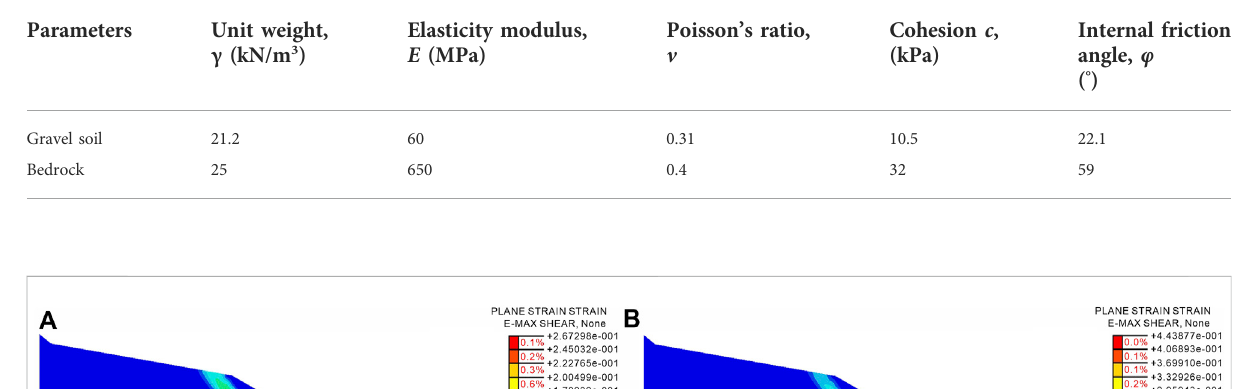
TABLE 2 Physical and mechanical parameters of soil and rock martials.